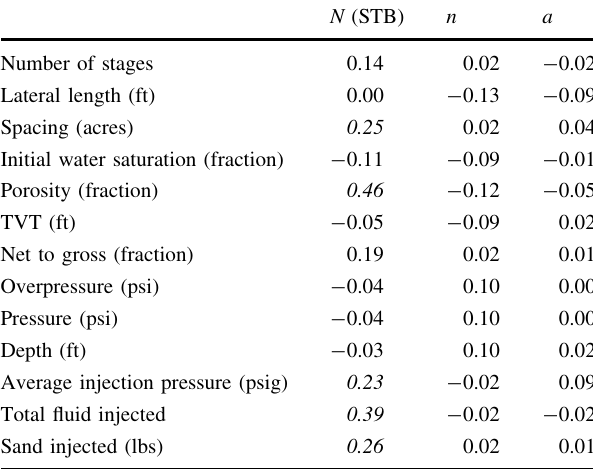
Table 6 Summary of the computed correlation coefficient between Table 7 Reservoir and well completion properties used in the frac- the model parameters and the reservoir and model completion prop- tional factorial design of experiments used to build the numerical erties for the logistic growth model simulation N (STB)